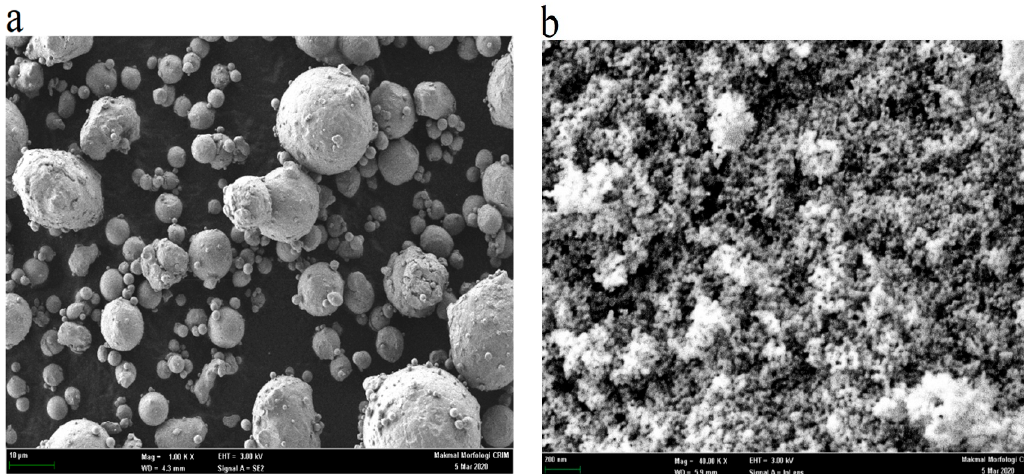
Figure 1. Field Emission Scanning Electron Microscopy (FESEM) micrographs of: ( a ) SS 17-4PH; and ( b ) 3YSZ powder.